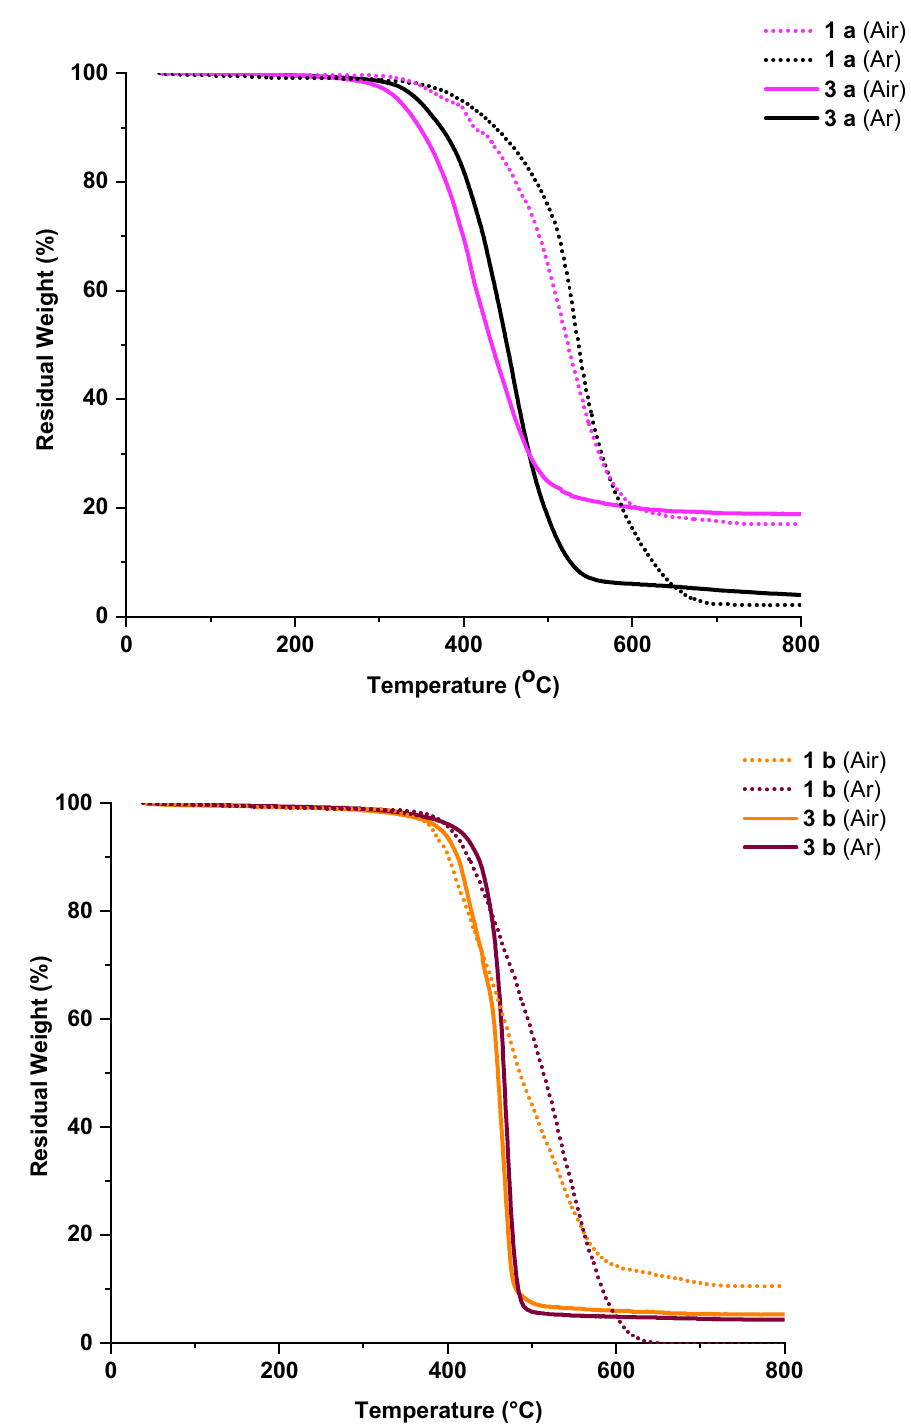
Figure 12. Thermogravimetric analysis (TGA) curves for compounds 1 a,b and 3 a,b in air and argon ◦ at the heating rate of 10 °C/min. at the heating rate of 10